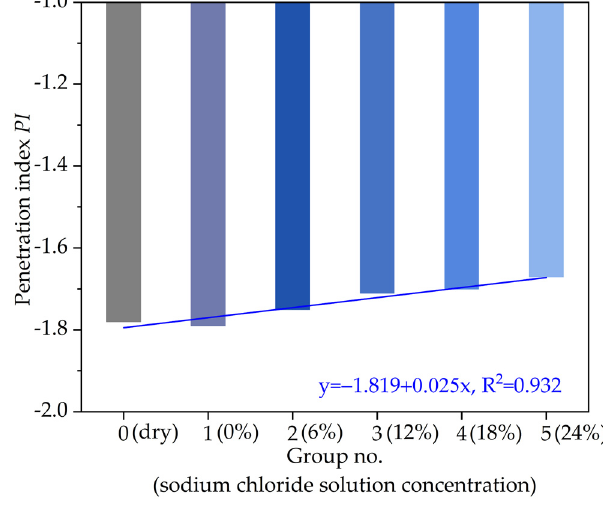
Figure 7. The variation of PI with different chloride salt concentrations.